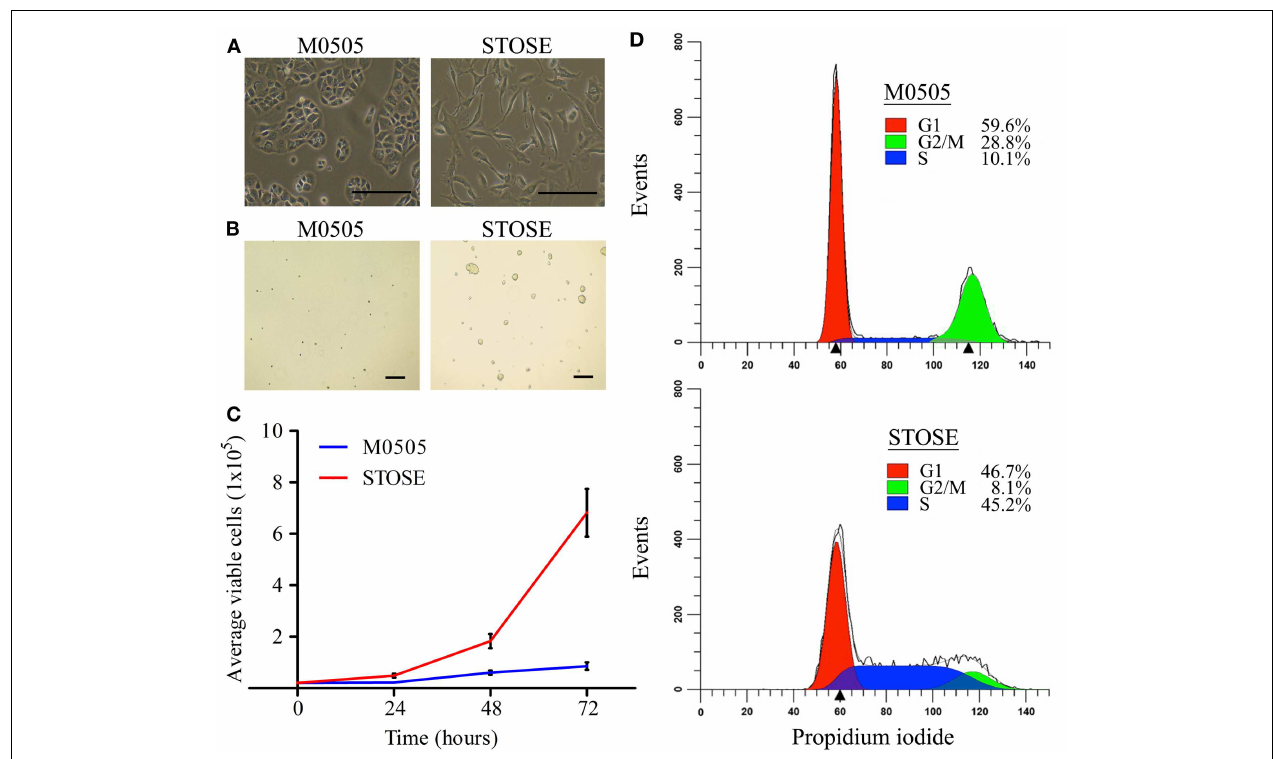
over 3days. Error bars represent standard error of the mean (SEM). p < 0.001, two-way analysis of variance. (D) Cell cycle analysis of M0505 and STOSE cells. Cells were incubated with the fluorescent dye propidium iodide and analyzed by flow cytometry.The average percentage of cells in G1, S, and G2/M for STOSE cells and M0505 cells is shown ( n =